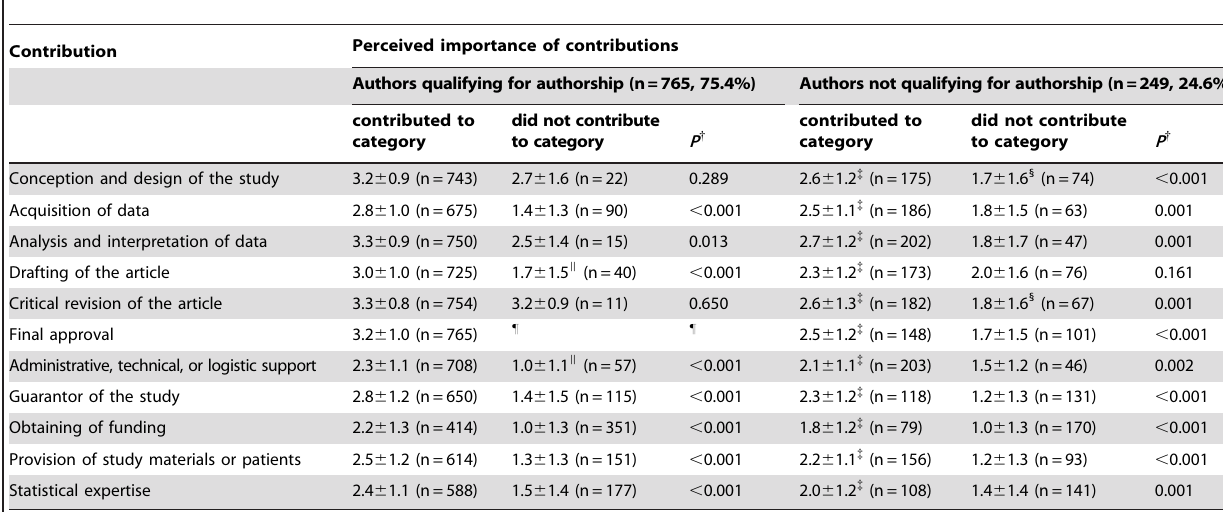
Table 1. Perceived importance of contribution categories (mean 6 standard deviation of the score on the scale from 0 to 4) of authors who were or were not identified as qualifying according to ICMJE criteria*.